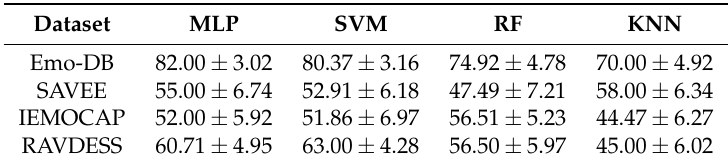
Table 3. Weighted average recall and standard deviation of speaker-independent SER experiments without feature